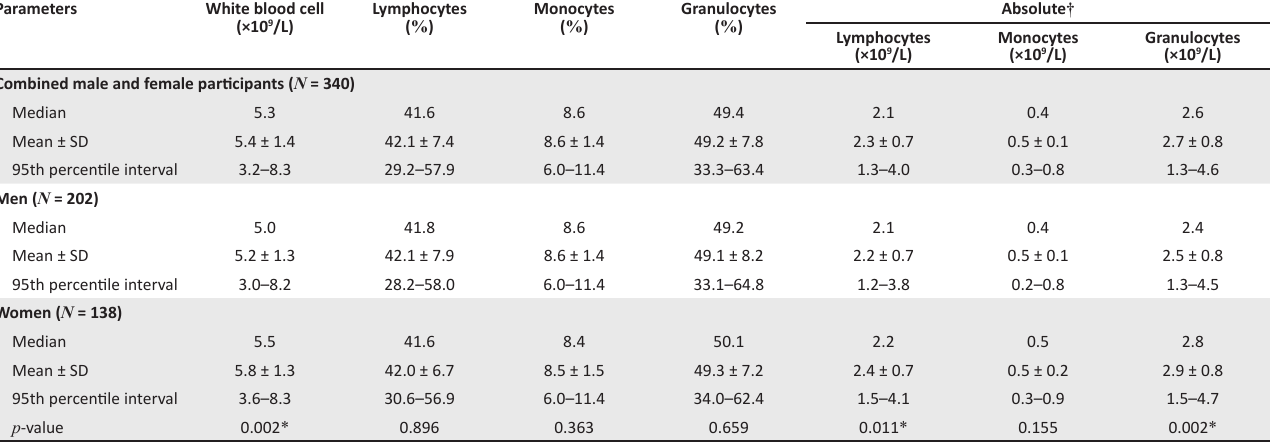
Lymphocytes Monocytes Granulocytes Absolute † (×10 9 /L) ( % ) ( % ) ( % ) Lymphocytes Monocytes Granulocytes (×10 9 /L) (×10 9 /L) (×10 9 /L)